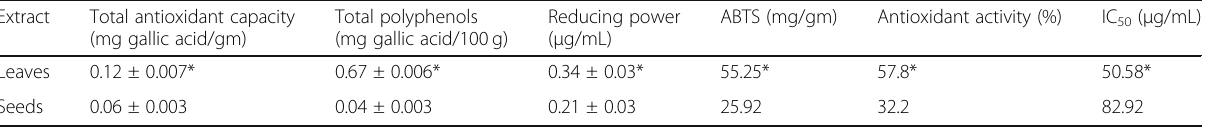
Table 1 Total antioxidant capacity and free radical scavenging activity in M. oleifera leaves and seeds extracts Extract Total antioxidant capacity Total polyphenols (mg gallic acid/gm) (mg gallic acid/100 g) Leaves Seeds *The most effective extract, values expressed as mean ± SE of four